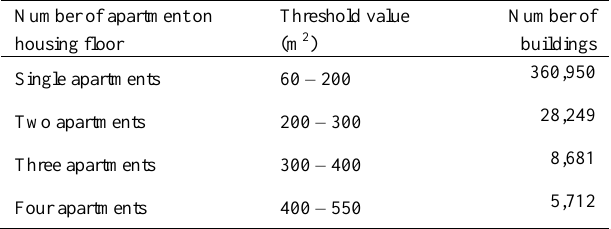
Table 1. Threshold values of residential